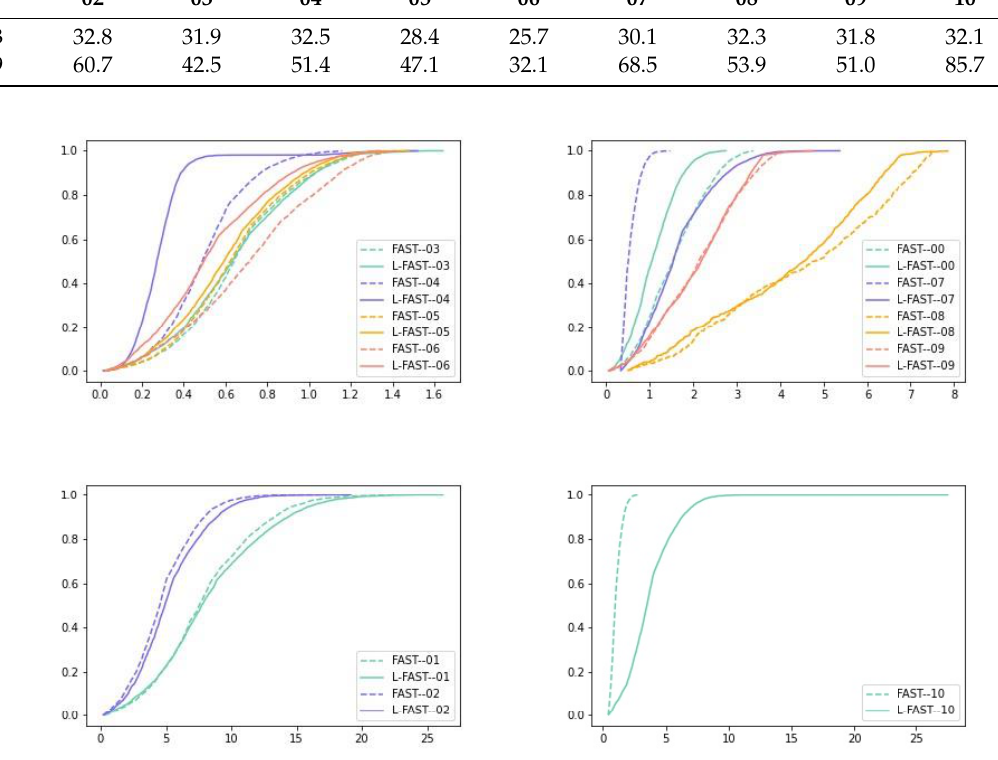
() c Figure 12. The CDFs of each Figure 12. The CDFs of each sequence. Table 4. The RMSE, min and max errors of ATE for sequences from 00 to 10 (unit: m).